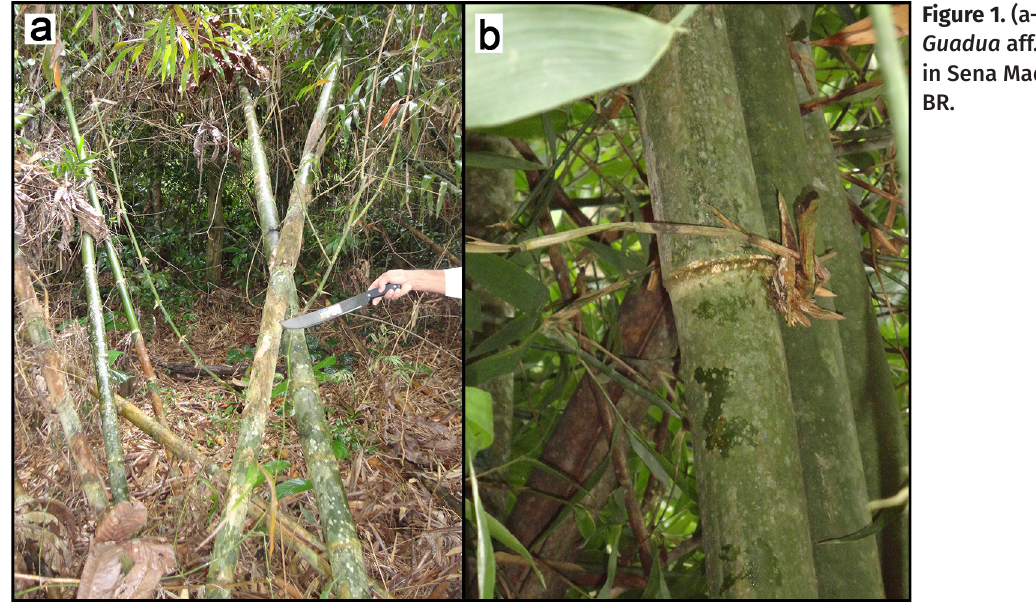
Figure 1. (a–b) Culms